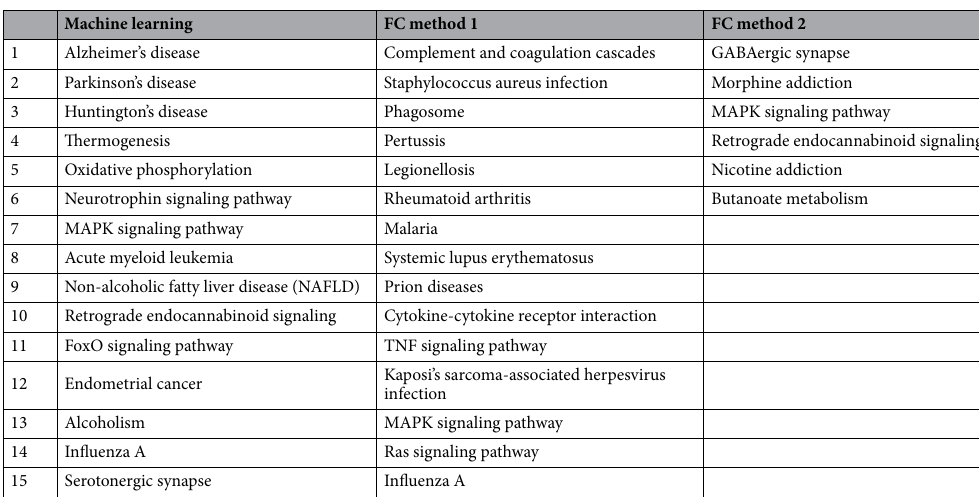
Table 1. Enriched KEGG pathways of genes identified by machine learning and conventional fold-change (FC) methods, respectively.